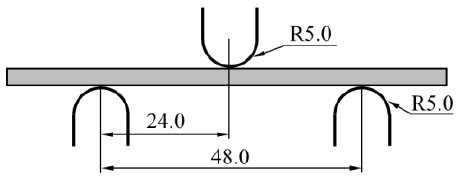
Figure 3. Three-point bending test loading schematic.